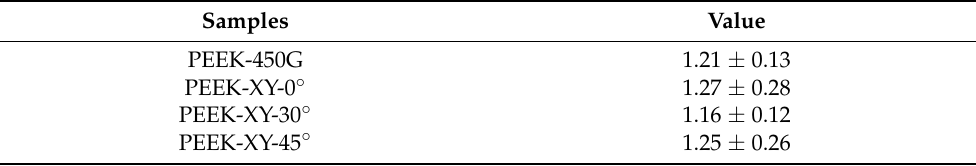
Table 2. The obtained I 1146 /I 1598 band ratios.